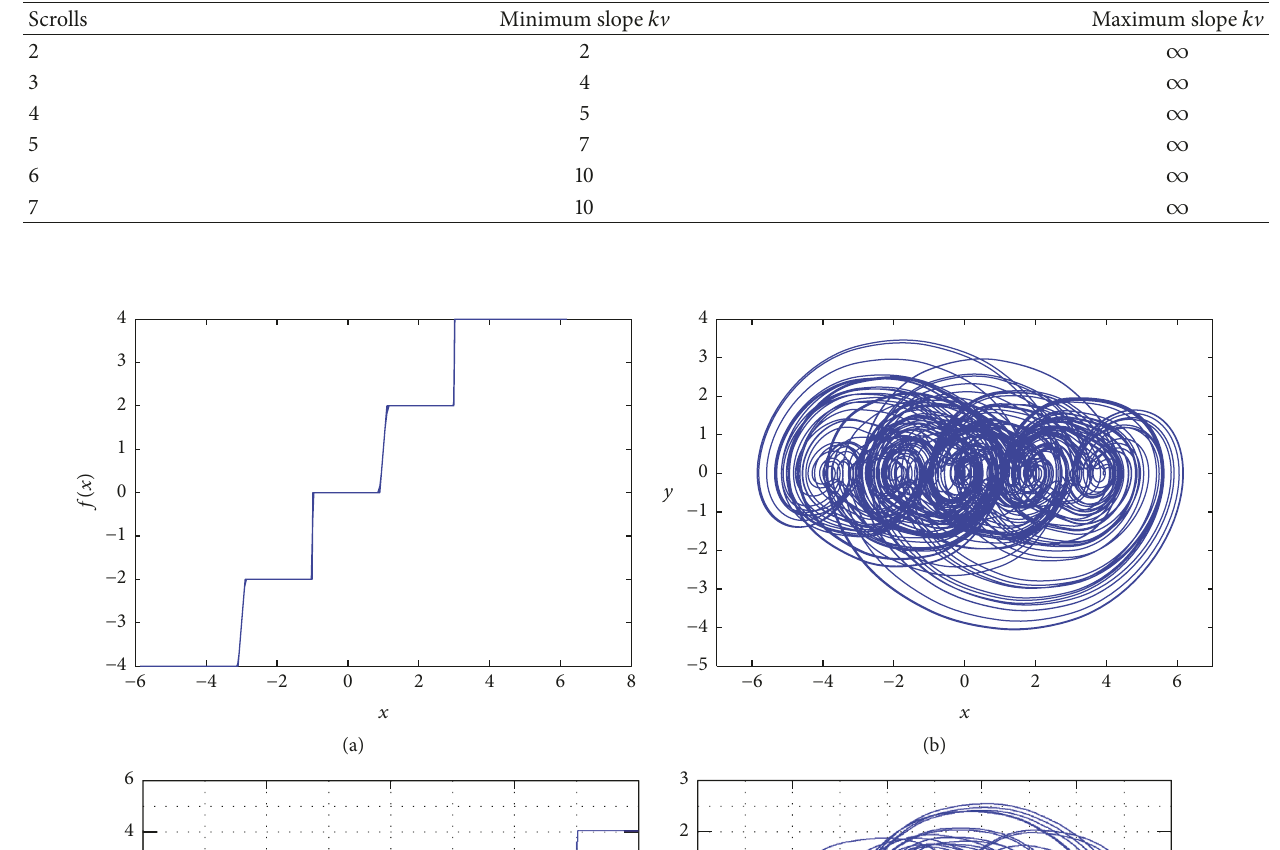
Table 1: Values of the slopes computed by MATLAB.